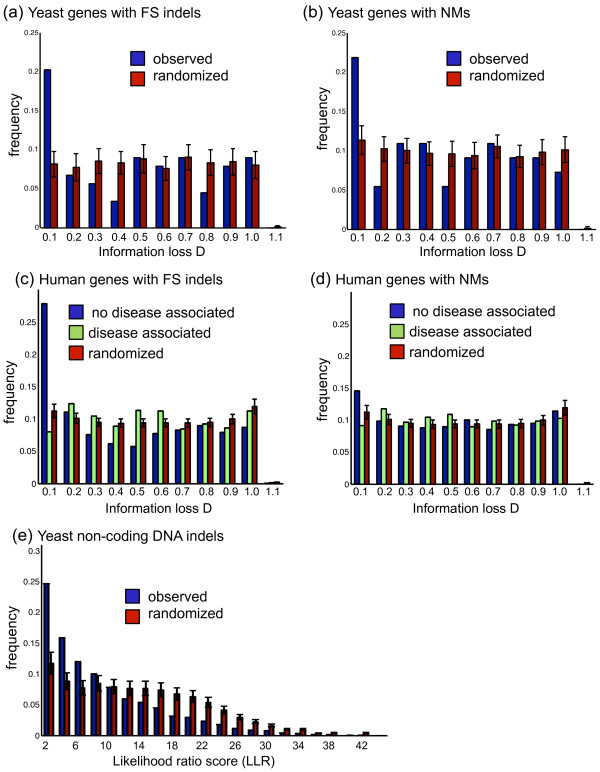
Randomization experiments. (a) Distribution of the information loss caused by the FS indels in the yeast population (blue) compared to the density of a set of randomly distributed FS indels throughout the same set of yeast genes (red). (b) Distribution of the information loss caused by the NMs in the yeast population (blue) compared to a set of randomly distributed NMs throughout the same set of yeast genes (red). (c-d) Distributions of FS indels and NMs in the human population (dbSNP [9]), respectively, with respect to the information loss they cause. For each type of variation, this distribution is different when compared to the variations with records of disease association (green) and variations that do not have such records (blue). A set of randomly generated FS indels (red) shows a similar distribution to those that are associated with diseases. (e) The distribution of DNA sites that harbour indels with respect to their LLR score is compared to the distribution of DNA sites randomly chosen from 1000 bp upstream of all genes in the yeast dataset. In panels a and b, the "randomized" histogram bars represent the mean of 100 random samplings of the data, and the error bars represent the standard deviation observed over the 100 samplings, while in panels c-e the "randomized" histogram bars represent the mean of 50 random samplings of the data, and the error bars represent the standard deviation observed over the 50 samplings.